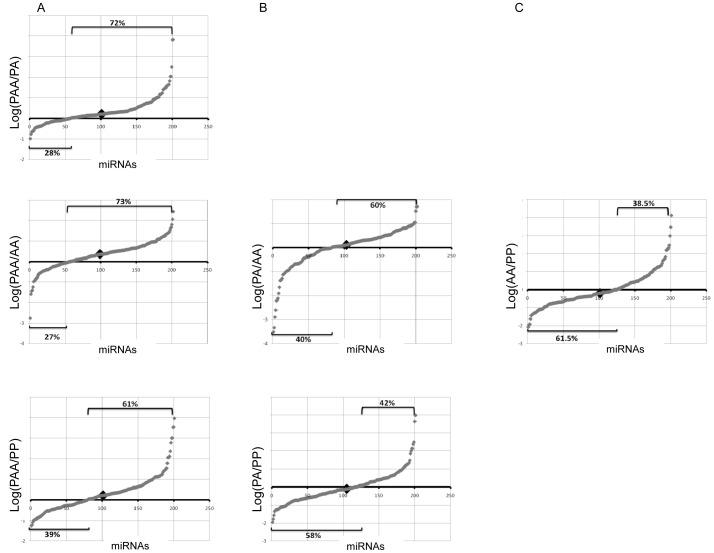
Differences in global miRNA expression profile.Differences related to A) allopolyplodization and B) hybridization. C) Differential expression profile between the parental species. Logarithmized ratios of gene expression for each miRNA were plotted producing a characteristic crescent curve where positive values indicate miRNAs with a higher expression and negative values miRNAs with a lower expression. ♦ Represents the median and its position indicate if most of the values are positive or negative. The percentages of positive and negative values are indicated.